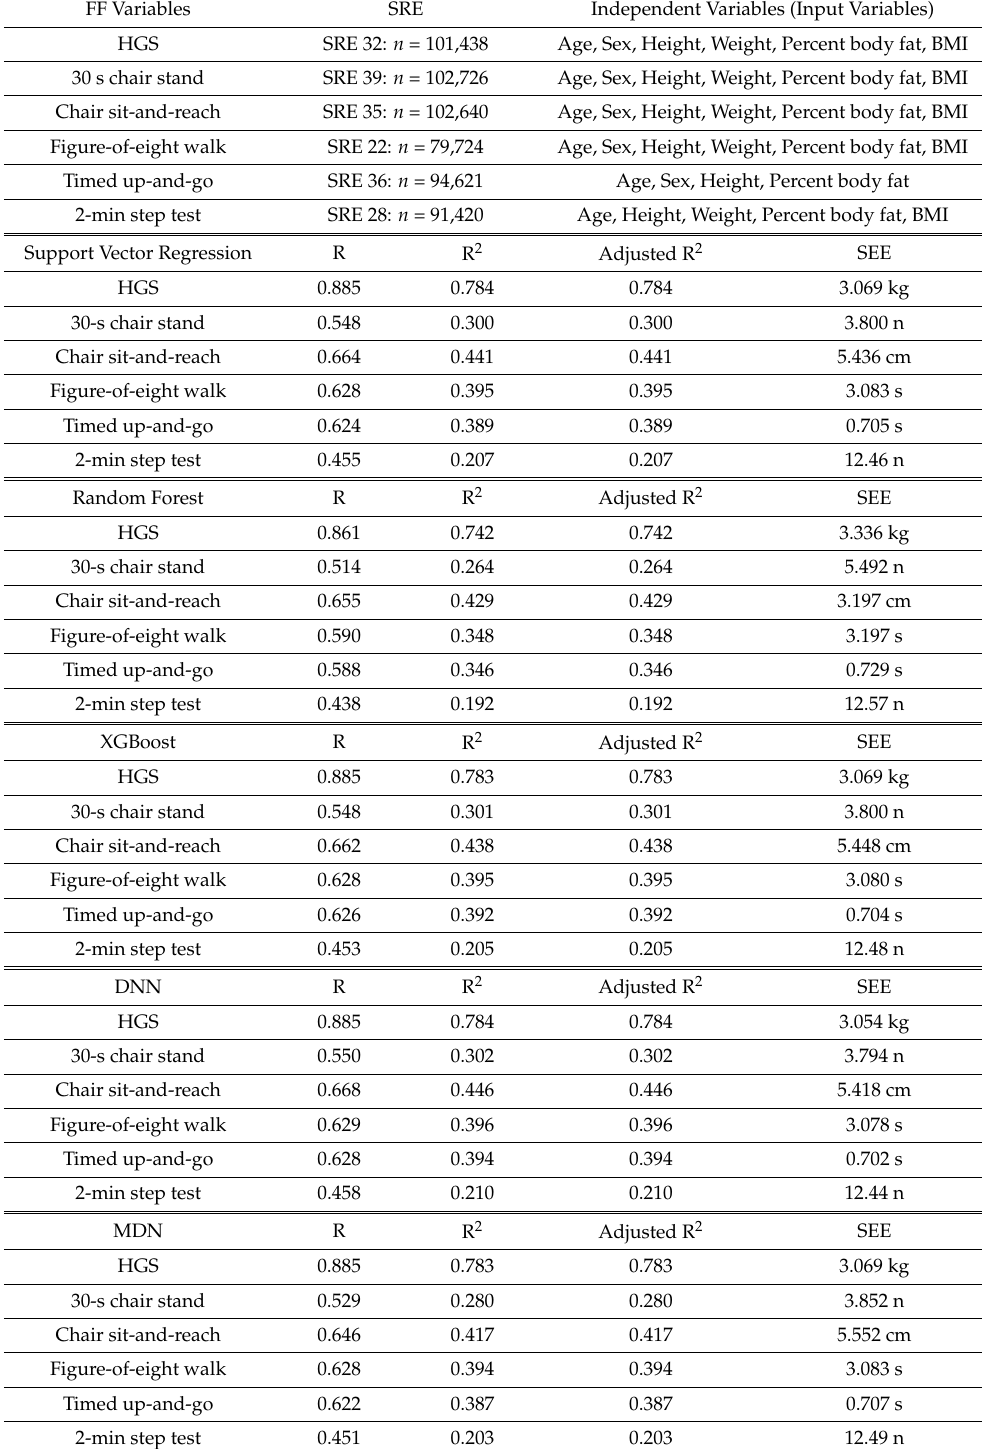
Table 5. Comparison of the estimated regression models predicting the FF variables without out- lier